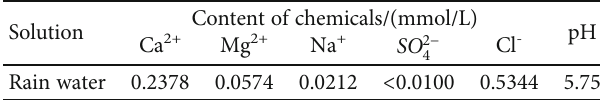
Table 1: Speci fi cs of water quality of rains in Longmen